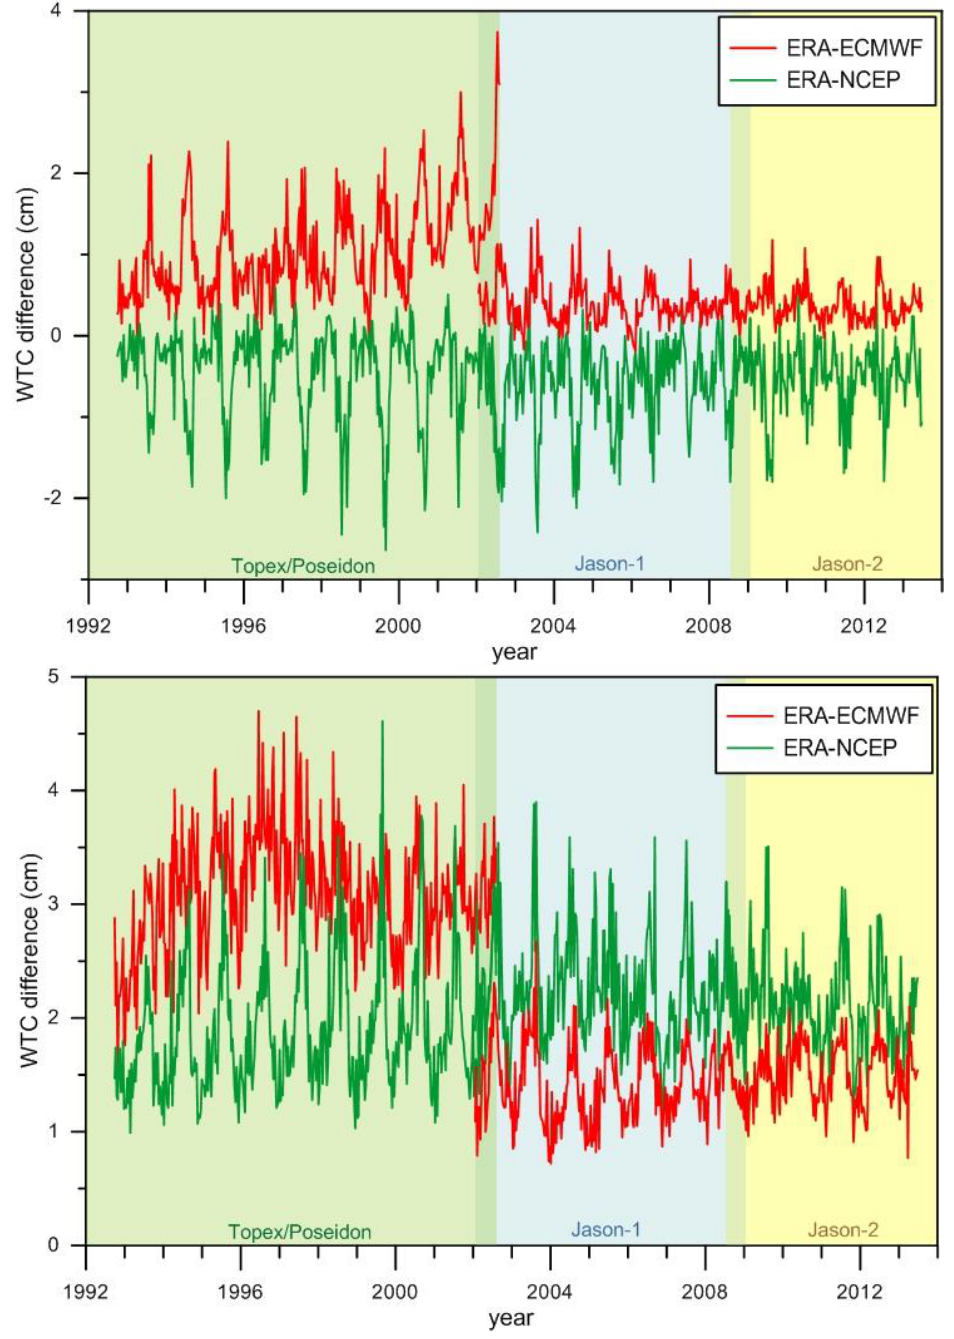
Figure 9. Mean cycle differences ( top ) and standard deviation of the differences ( bottom ) between the WTC from ERA Interim and from the ECMWF operational model (red) and from NCEP (green) for T/P Phase A, Jason-1 Phase A and